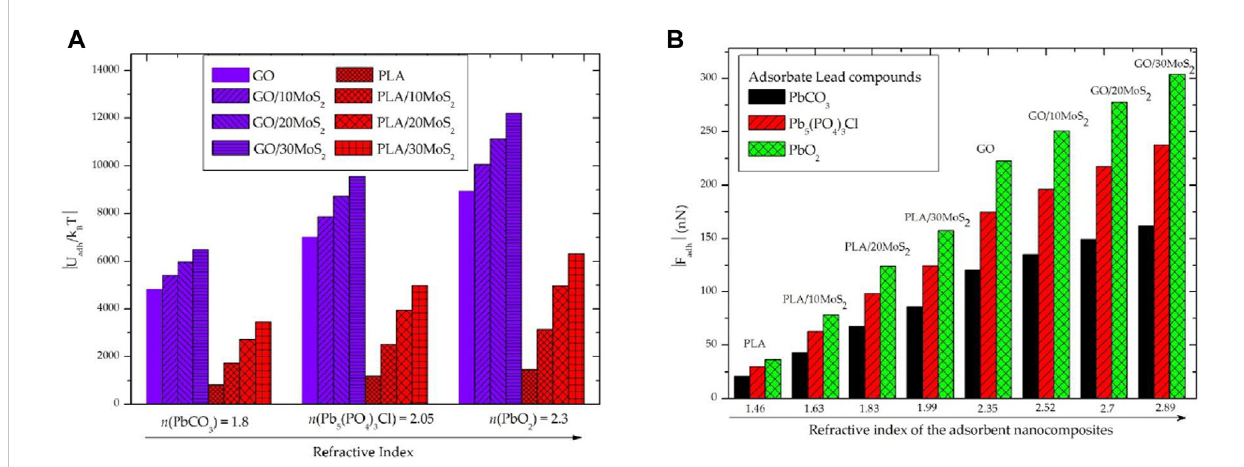
FIGURE 5 Evolution of the vdW adhesion energy and force corresponding to the physical adsorption of the “ PbCO 3 , Pb 5 (PO 4 ) 3 Cl, and PbO 2 ” lead compound adsorbates onto “ GO/MoS